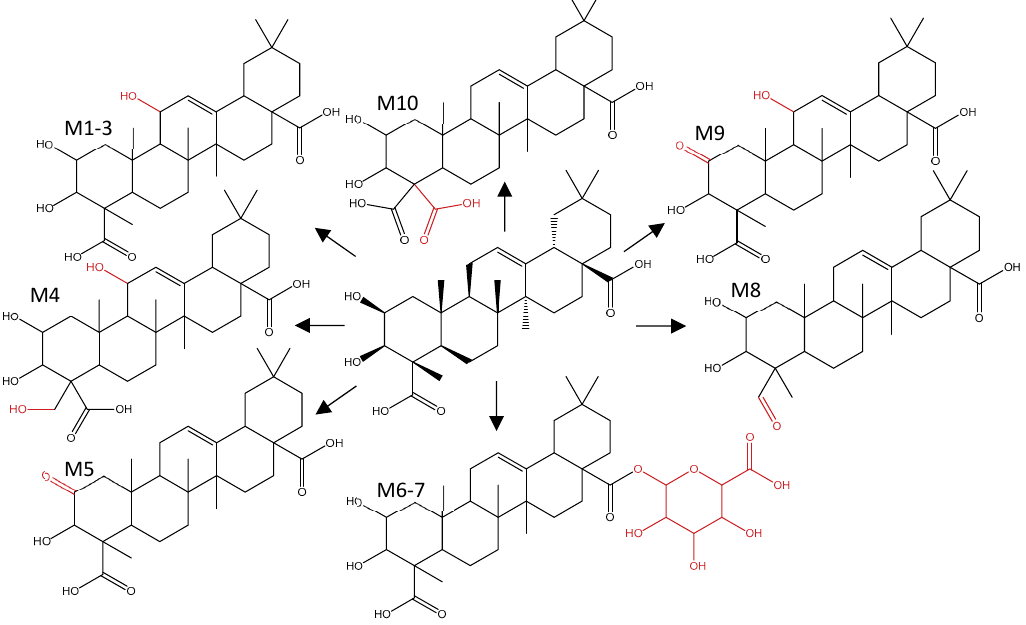
Figure 10. B Metabolic pathway of medicagenic acid after in vitro hepatic biotransformation.